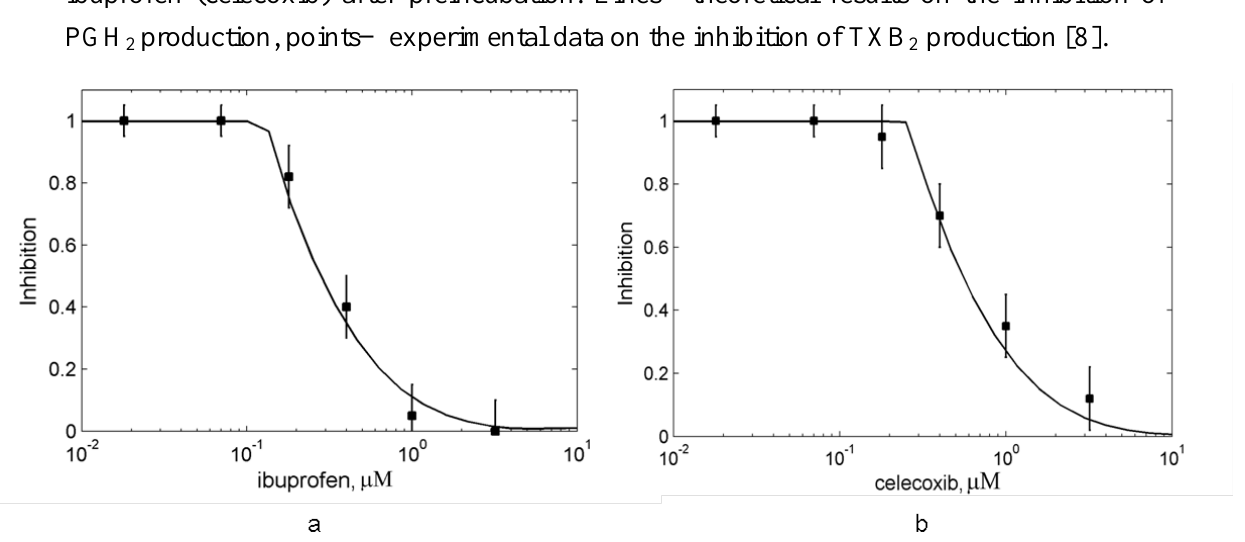
Figure 9. Effect of the suppression of aspirin-mediated inhibition of platelet PGHS-1 by ibuprofen and celecoxib. The dependence of platelet PGHS-1 inhibition on ibuprofen (a) and celecoxib (b) concentrations at the presence of 100 µ M aspirin at the full removal of ibuprofen (celecoxib) after preincubation. Lines—theoretical results on the inhibition of PGH production, points—experimental data on the inhibition of TXB 2